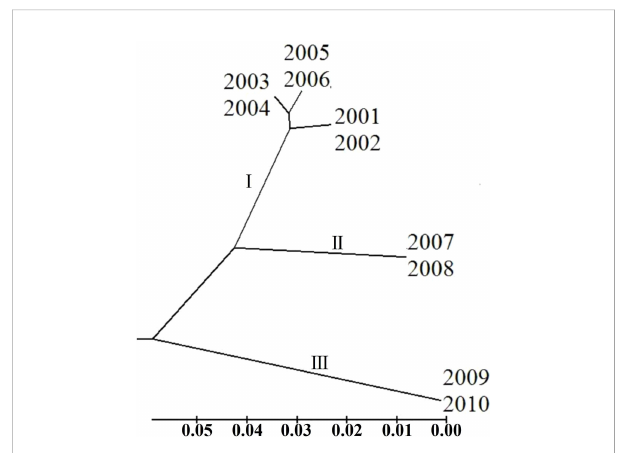
FIGURE 7 Phylogenetic tree of the 10 Puccinia triticina populations based on EST-SSR. The isolates of each year are regarded as a population.